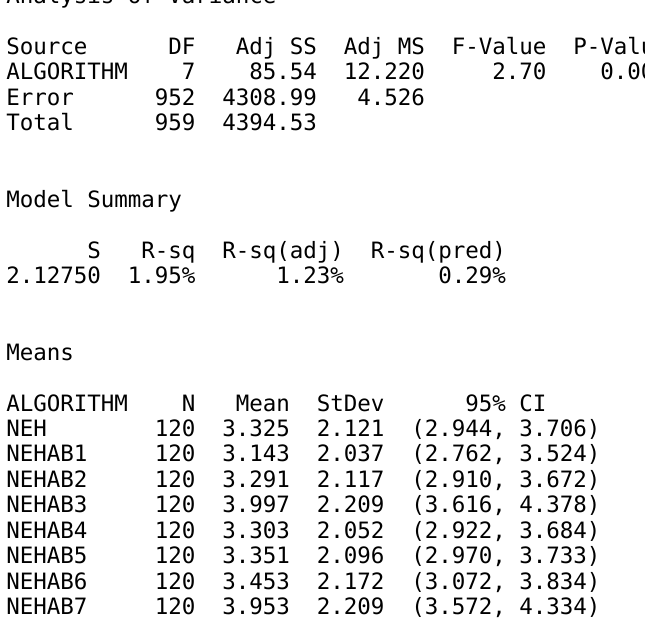
Fig. 6. One Way Normal Analysis of Means for Relative